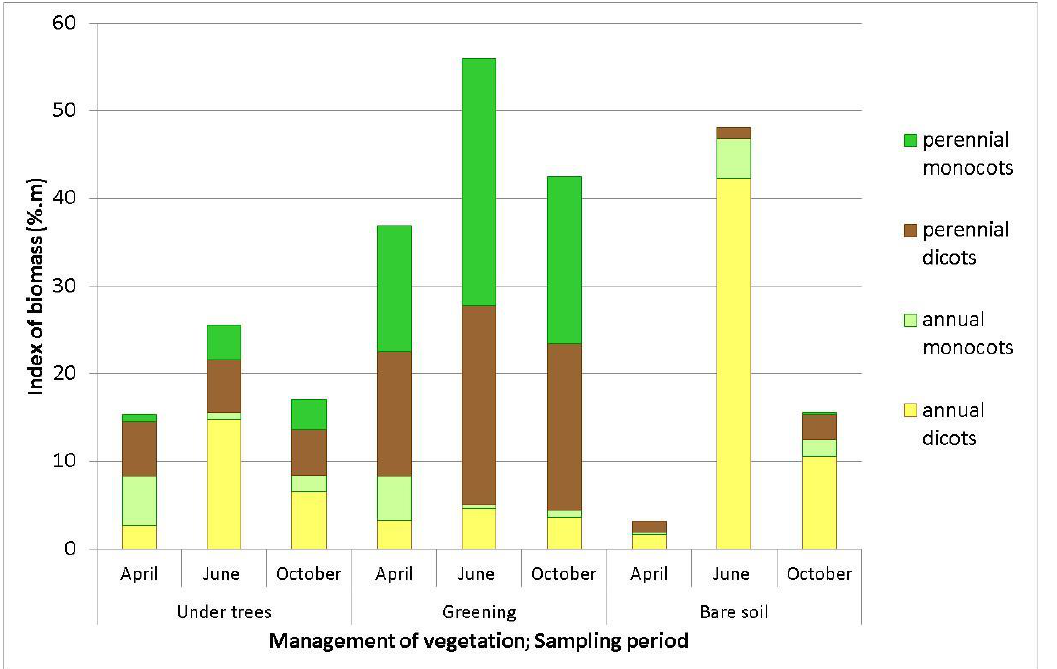
Figure 4. Values of biomass index at different sites in the orchard.